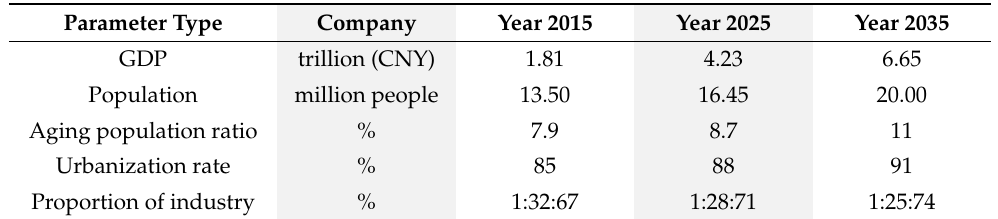
Table 2. BAU scenario